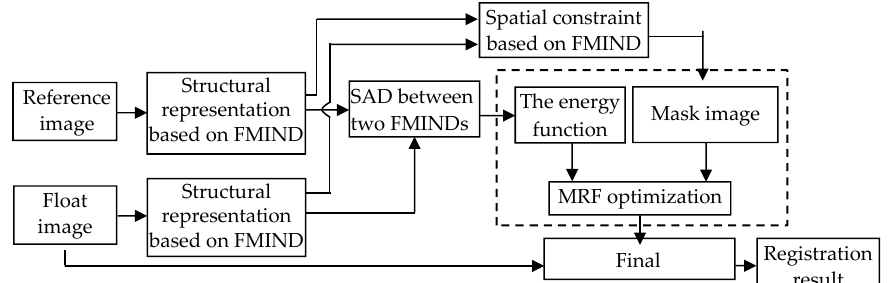
Figure 1. Flowchart of the foveated modality independent neighborhood descriptor (FMIND) based image registration.